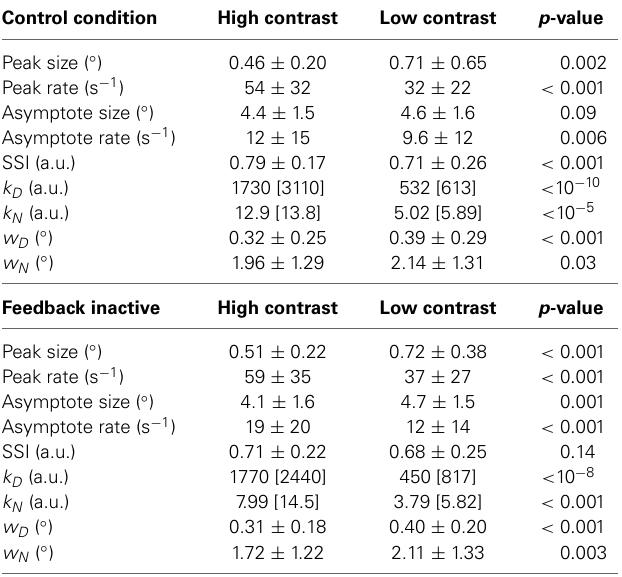
Table 3 | Contrast’s effect on area summation curve features and model parameters.